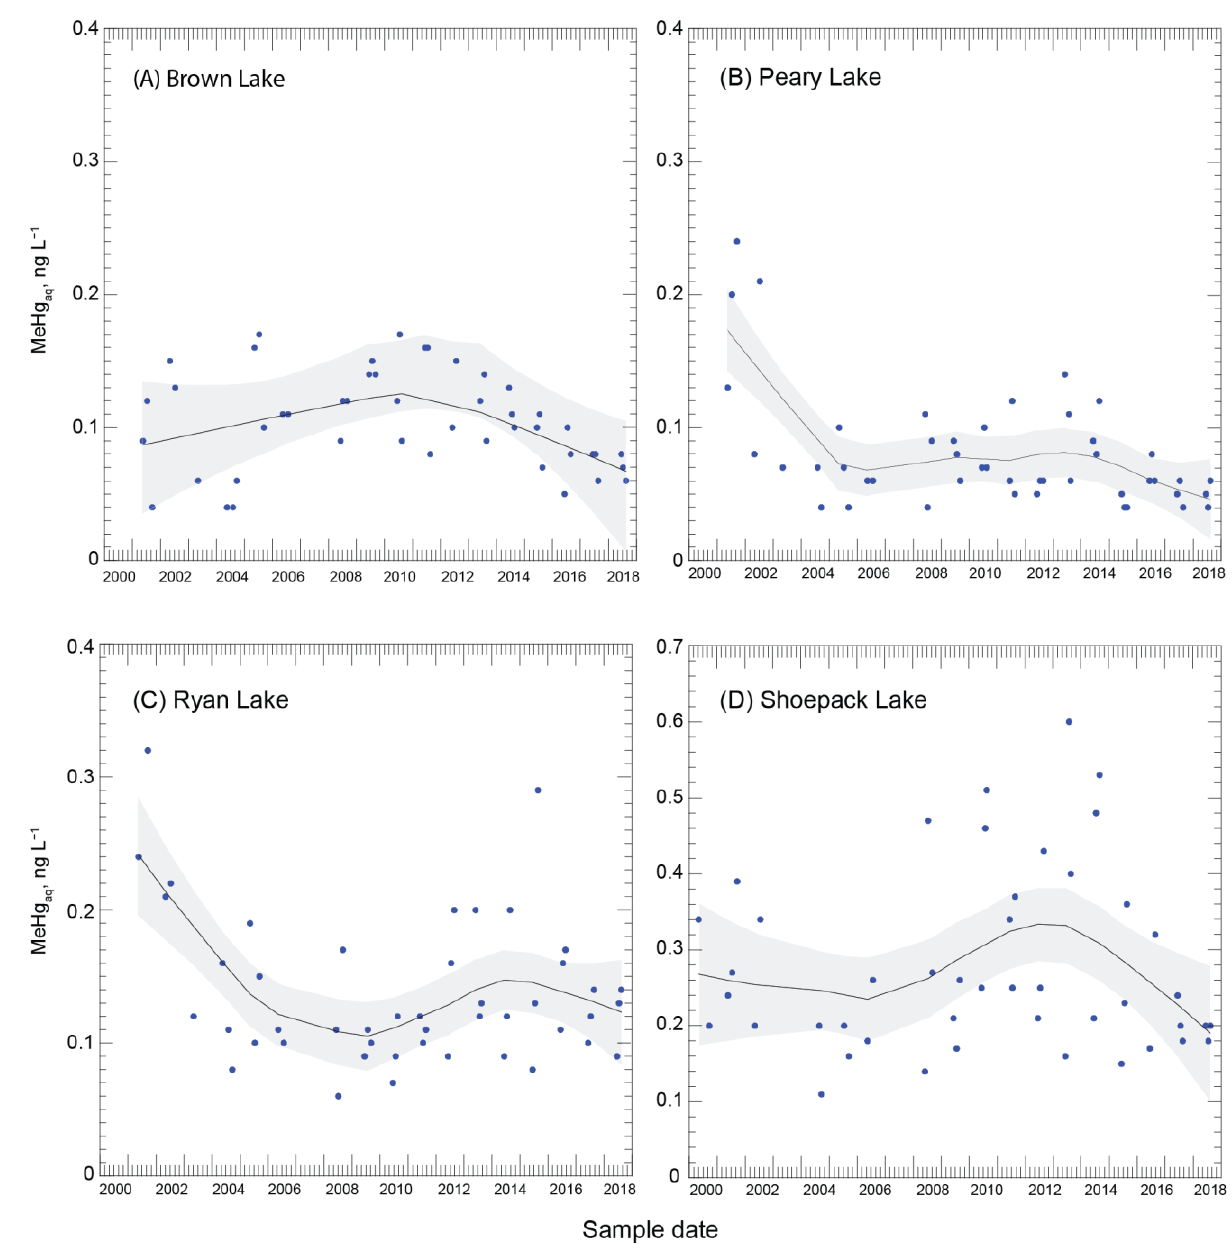
Figure 3. Time series plots for methylmercury (MeHg aq ) in epilimnetic lake water. Smooth lines are locally weighted regression lines; smoothing parameters, selected as described in the methods section: ( A ) Brown Lake, smoothing parameter = 0.713; ( B ) Peary Lake, smoothing parameter = 0.424; ( C ) Ryan Lake, smoothing parameter = 0.489; and ( D ) Shoepack Lake, smoothing parameter = 0.633. Gray shading indicates the 95-percent confidence interval. A high outlier for Brown Lake (reported concentration 0.51 ng L −1 for 30 August 2012) is omitted from the plot and regression.